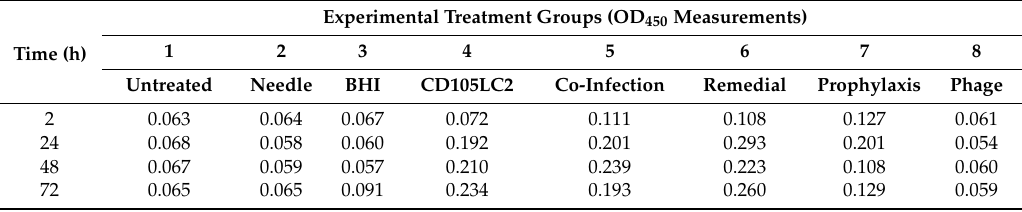
Table 3. Average ELISA readings of C. difficile toxins from G. mellonella guts treated with phage cocktail. Time (h)